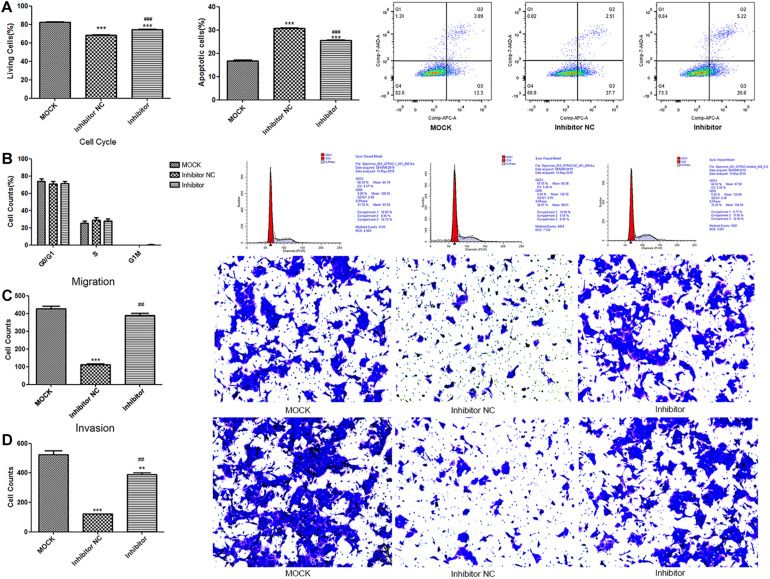
The results for the determination of cytological effect in the MOCK, inhibitor NC, and inhibitor groups. The quantitative statistics and representative images of cell apoptosis (A) and cell cycle (B) determined by flow cytometer; The quantitative statistics and representative images of crystal violet stained migrated cells (C) and invaded cells (D) determined by Transwell assay. Cell apoptosis was detected by **p < 0.01 and ***p < 0.001 compare to the MOCK group; ##p < 0.01 and ###p < 0.001 compared to NC group. MOCK: CFPAC-1 only (without MSC exosome); Inhibitor NC: CFPAC-1 + MSC-hsa-miR-143-3p inhibitor negative control; Inhibitor: CFPAC-1 + MSC-miR-143 inhibitor group.